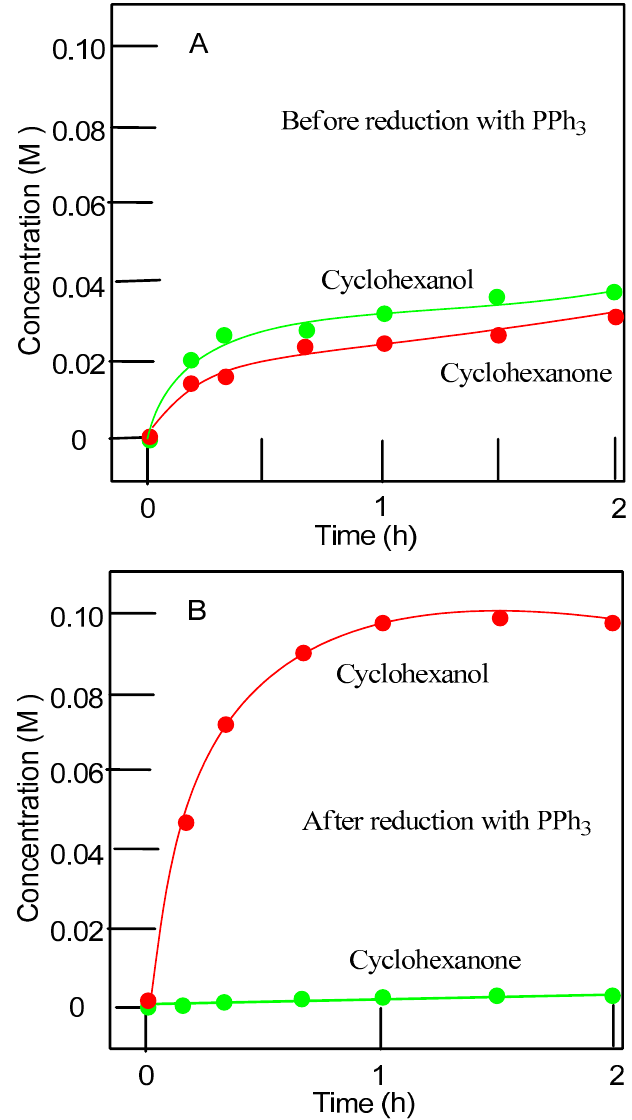
Figure 7. Accumulation of cyclohexanol and cyclohexanone in the oxidation of cyclohexane (0.46 M) with hydrogen peroxide (2.0 M, 50% aqueous) catalyzed by compound 1 (5 × 10 − 4 M) in MeCN at 50 °C. Concentrations of cyclohexanone and cyclohexanol were determined before (graph A ) and (graph B ) after reduction of the aliquots with solid PPh 3 (according to the Shul’pin method [45–51]).